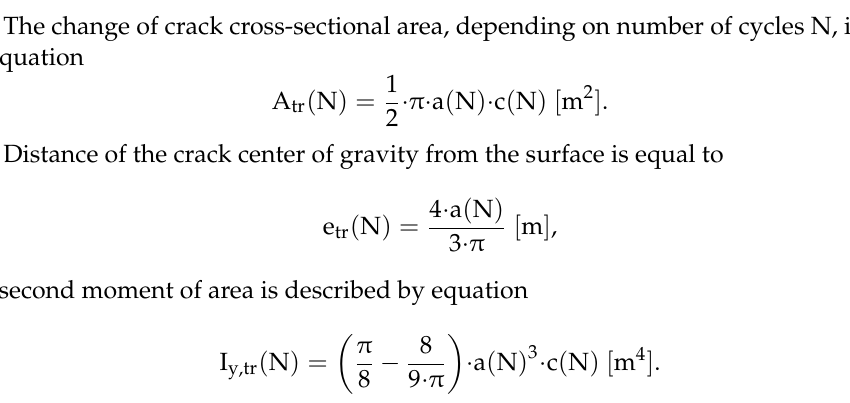
Figure 2. Shape and dimensions of a crack propagating from